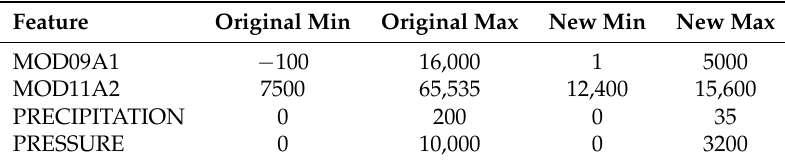
Table 1. The actual data range of